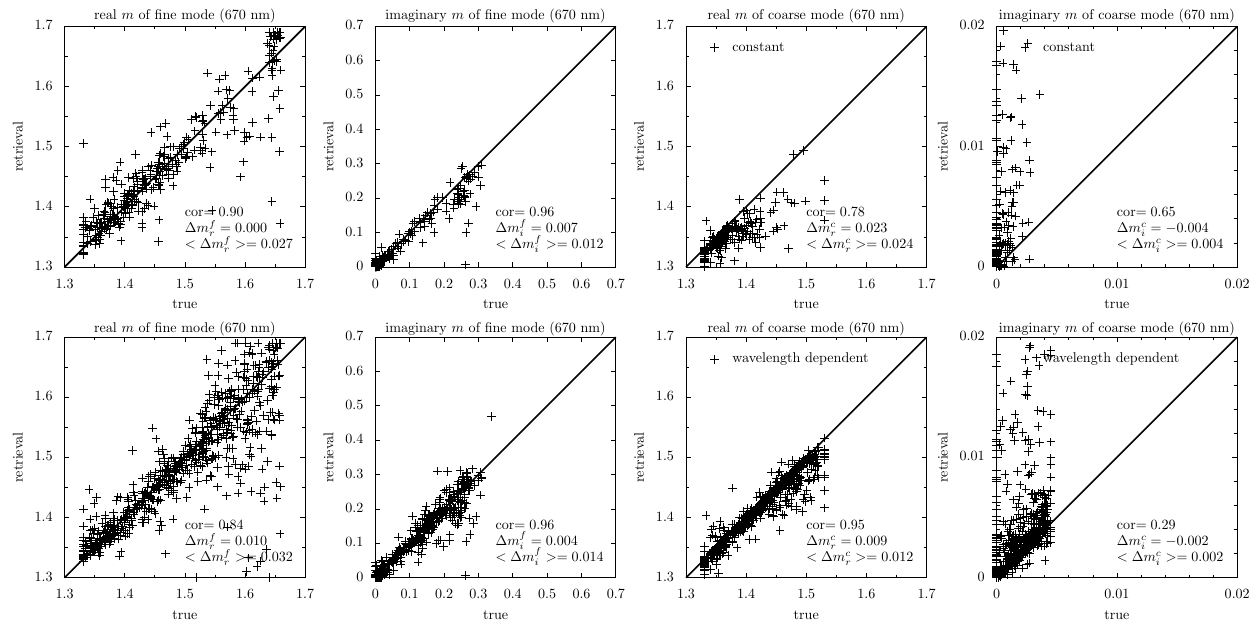
Figure 3. Comparison between accounting for (top panel, for χ 2 ≤ 2 . 0, 35 . 3% cases converged) and not accounting for (bottom panel, 75 . 1% converged) spectral variation of refractive index in synthetic retrievals. The correlation coefficients (cor), mean error ( (cid:49)m ) and mean absolute error ( < (cid:49)m > ) between retrieved and true values of refractive index are